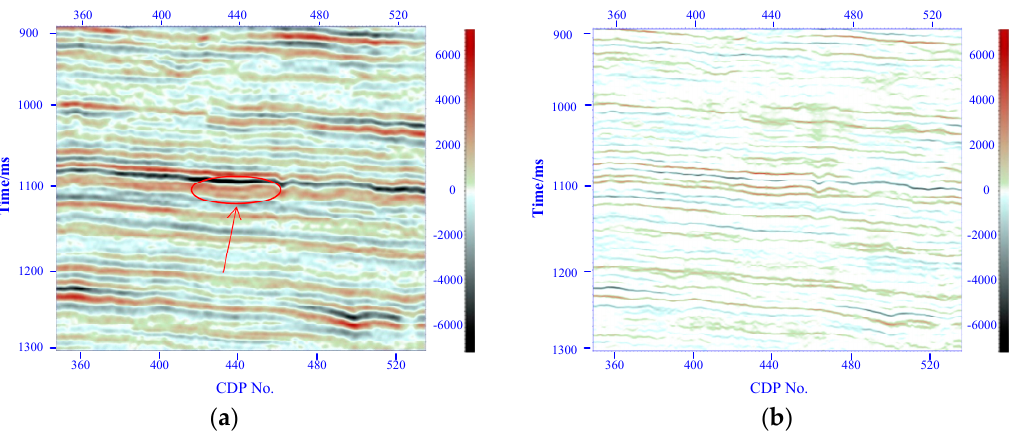
Figure 10. Field seismic data and its reflection coefficient inversion result. ( a ) Field seismic data; and ( b ) inversion result of the reflection coefficient.